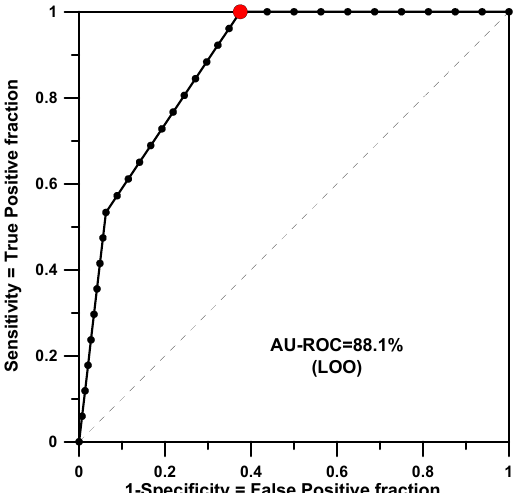
Figure 2. AU-ROC plot for RB obtained with a LOO cross-validation calculation.